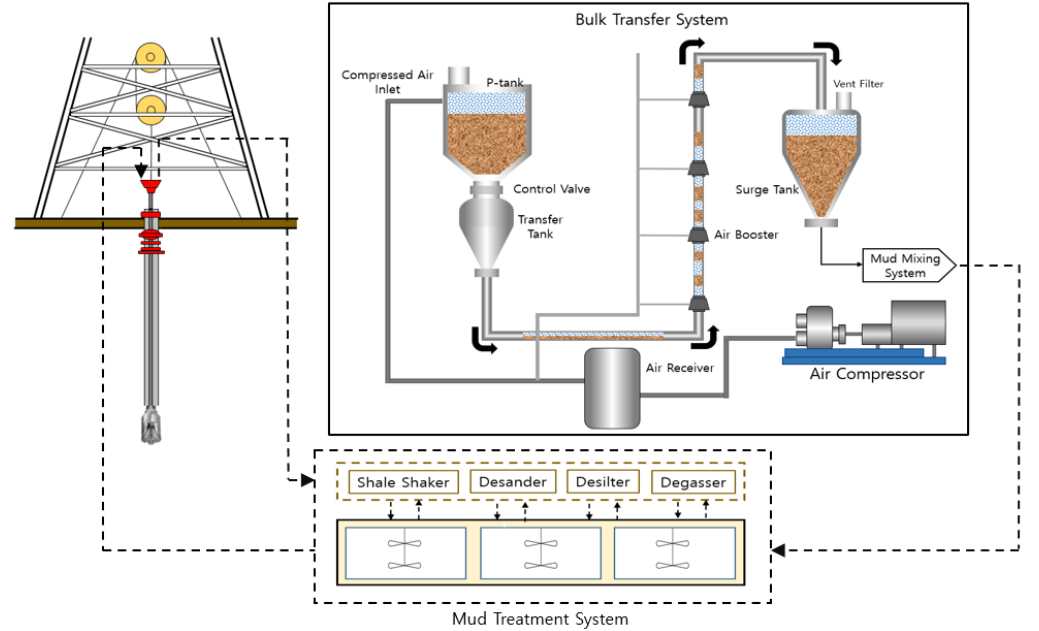
Figure 1. Schematic of mud circulation system, including MTS and BTS.